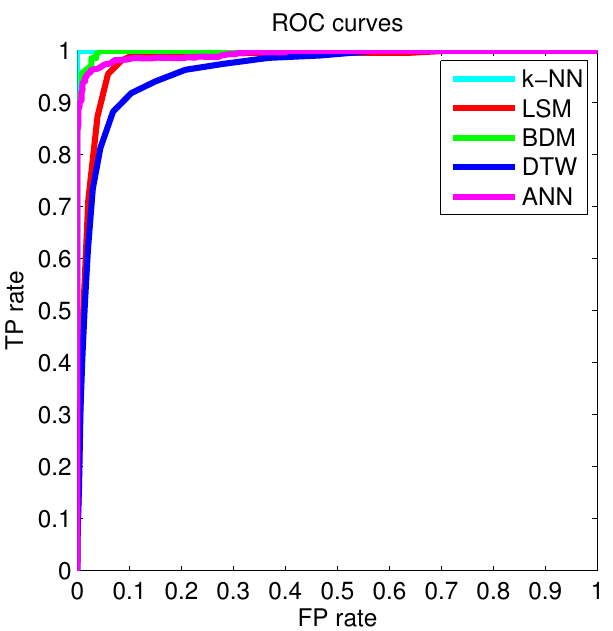
Figure 3. ROC curves for some of the classifiers.